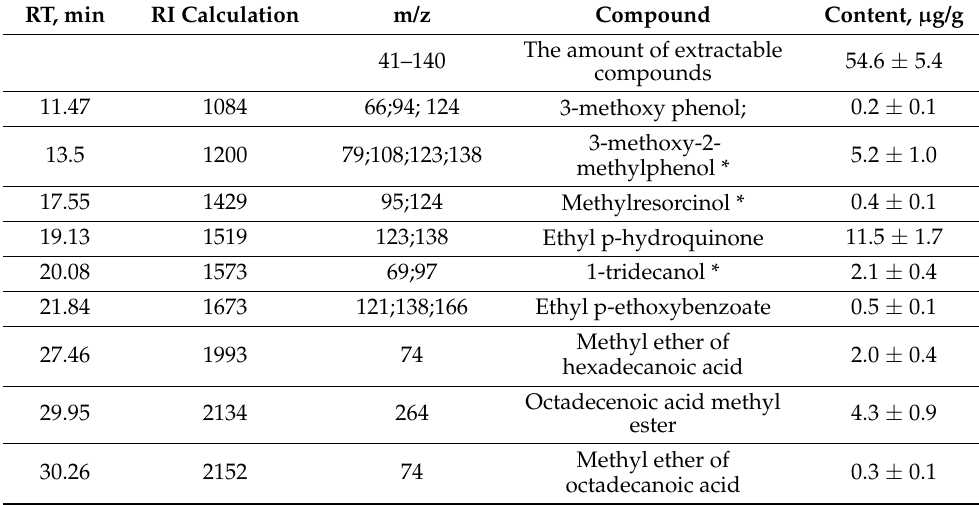
Table 2. Composition of nonprotein components of the aqueous extract of the U. dermestoides